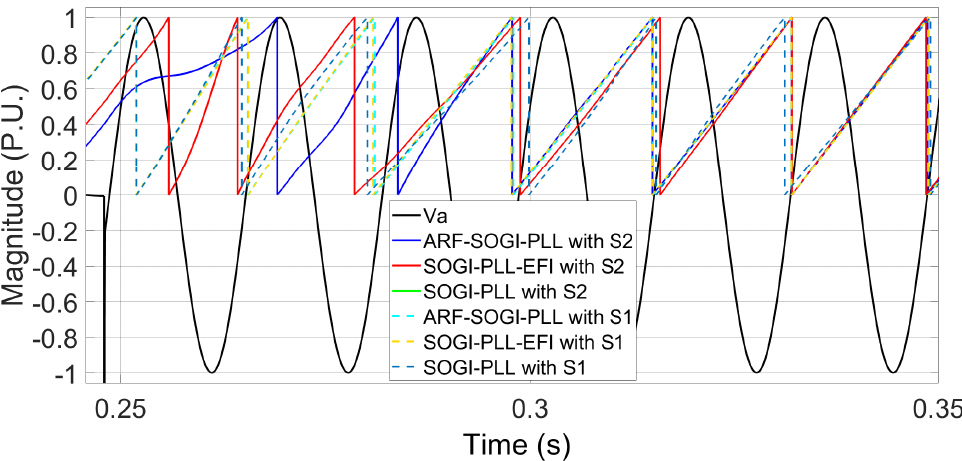
Figure 15. ω t during and after phase-to-ground short-circuit fault using a high and typical bandwidth in the control loop of the